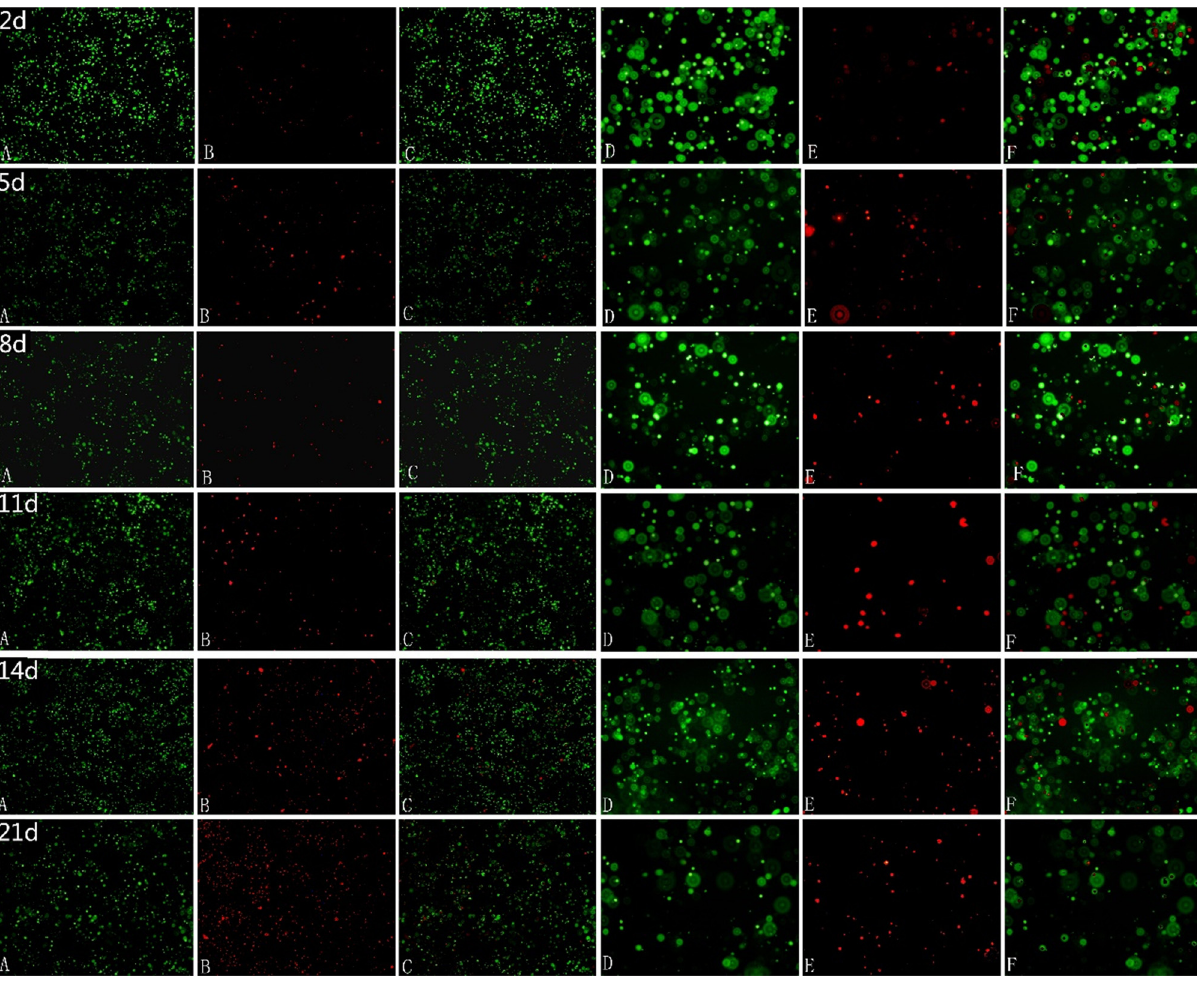
Figure 5: The representative images of A - cells staining by Calcein - AM ( green, live cell ) and PI ( red, dead cell ) are shown. The A - cell were cultured in vitro for 2, 5, 8, 11, 14, and 21 days. A, B and C were × 40 magni fi ed and displayed the same fi eld; A and B were synthesized C. D, E and F were × 100 magni fi cation and displayed the same fi eld; D and E were synthesized F. The green fl uorescence of live cells was very bright at 2 days, decreasing gradually to 8 days, then rise to the highest at 14 days, 21 days reduced to close to 8